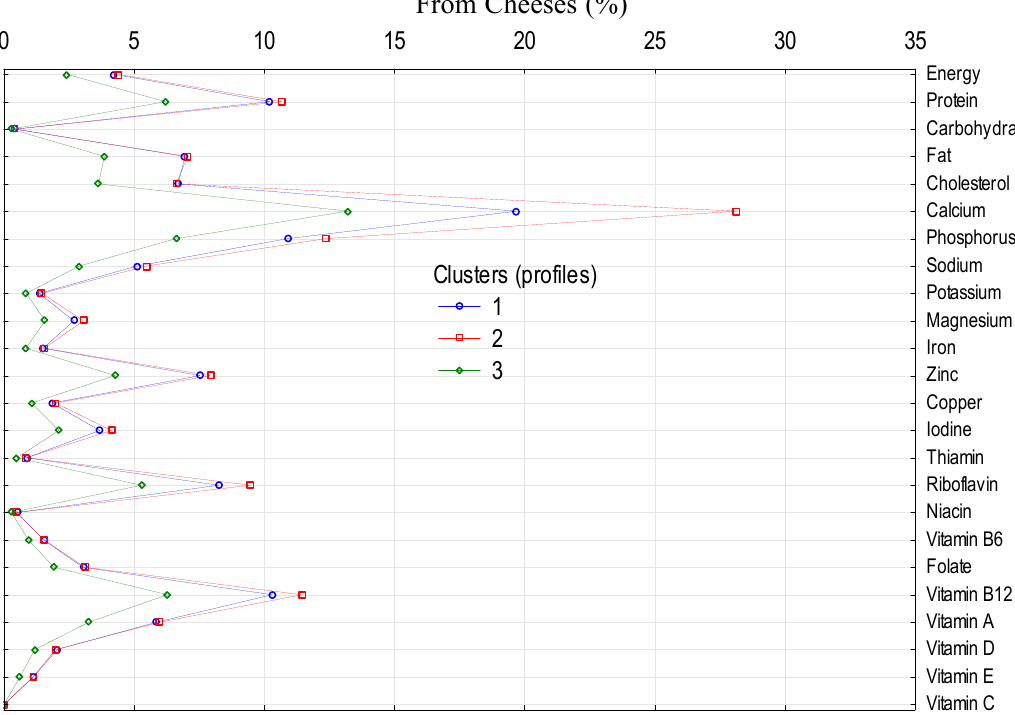
Figure 1. Cluster analysis: supply of energy and nutrients to the average Polish diet.